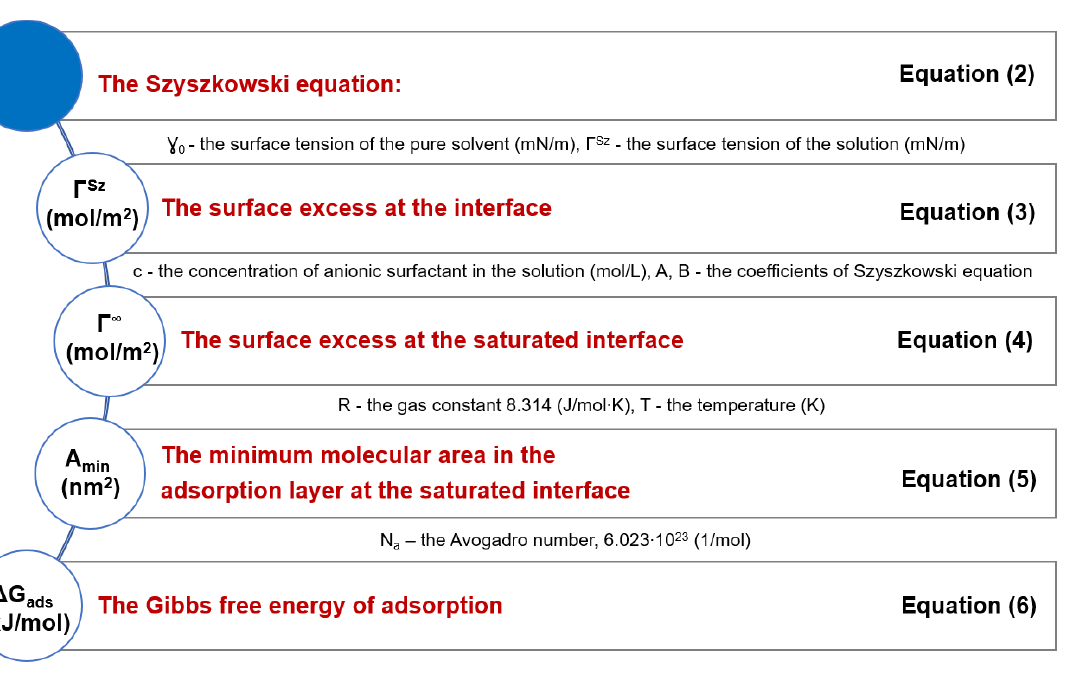
Figure 5. Characterization of the parameters used for the ABS and ABSNa50